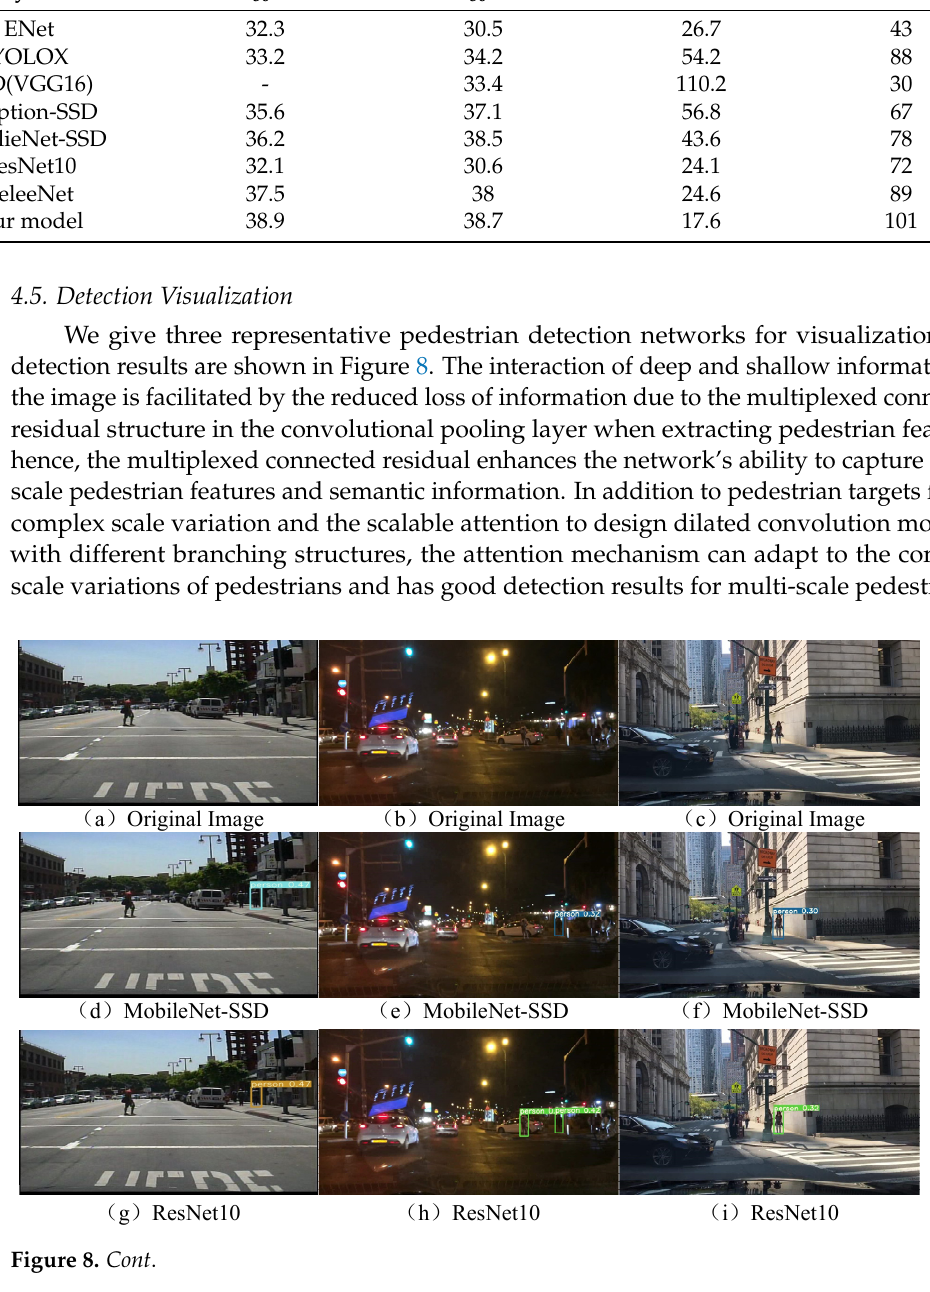
（ o ） FMRN Figure 8. Visual comparison with previous state-of-the-art methods on Caltech and BDD 100 K- Person dataset. 5. Conclusions In Section 4.2–4.4, we not only conduct ablation experiments to prove the effective- ness of each module, but also compare experiments in two datasets to show that our model has a small number of parameters, fast detection speed, and good detection effect. The main reasons are as follows. The multiplexed connection residual structure (MR) retains the characteristic infor- mation of the previous layer and passes the useful characteristic information to the output of the next layer. The MR improves the information transmission ability of the traditional methods, which is more conducive to the lightweight model to capture small-scale pedes- trian features. A lightweight scalable attention module (SA) is investigated to expand the respective field of the detection model. The branch structure of the SA module is selected to synchro- nize the feature dimensions, and the dilated convolution is introduced to expand the local respective field of the model. The SA module can eliminate the redundant channel infor- mation, which can further improve the adaptation ability of the model to deal with the issue of pedestrian scale variation.